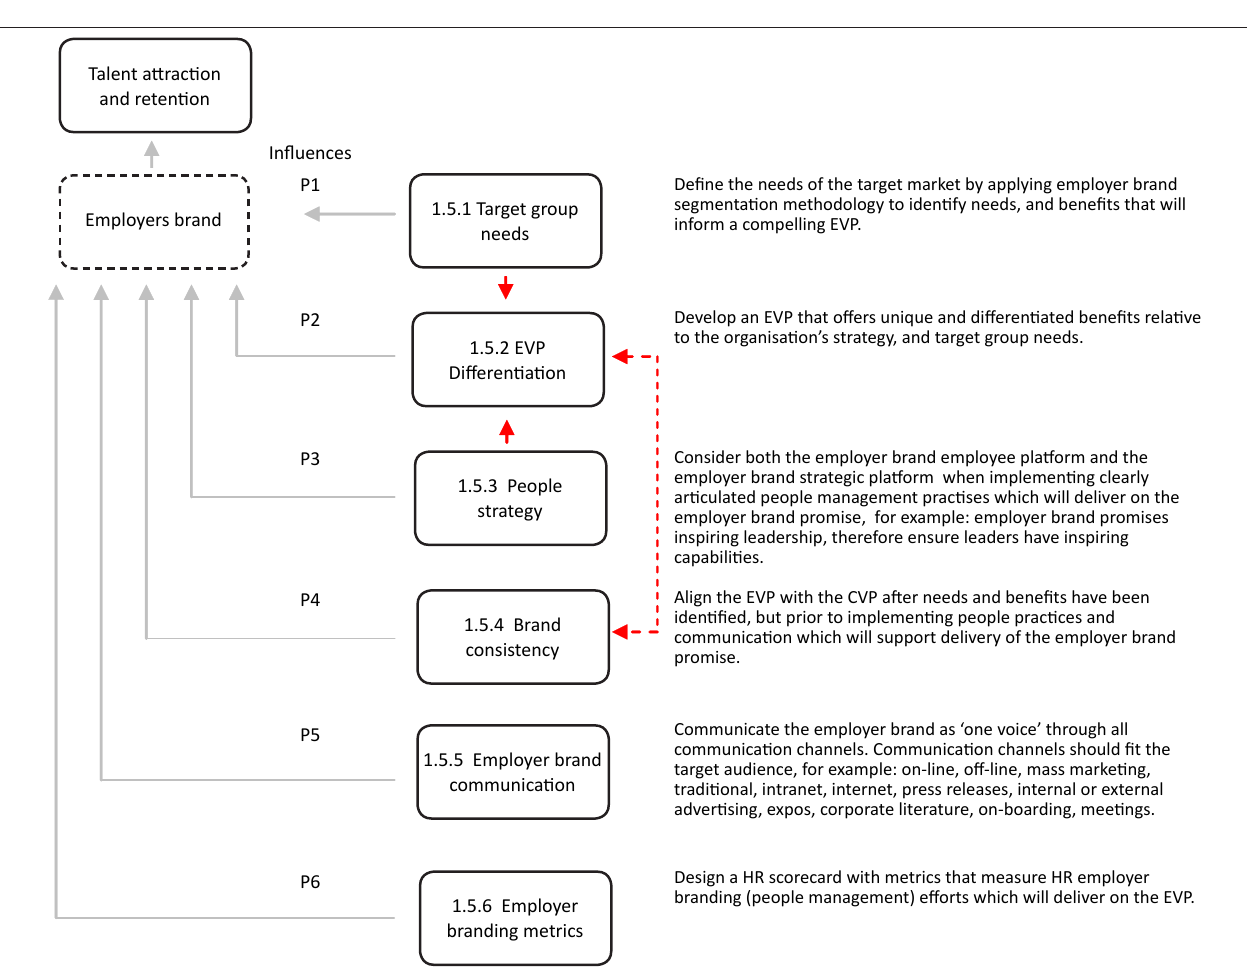
FIGURE 1: Employer Brand Predictive Model Theoretical